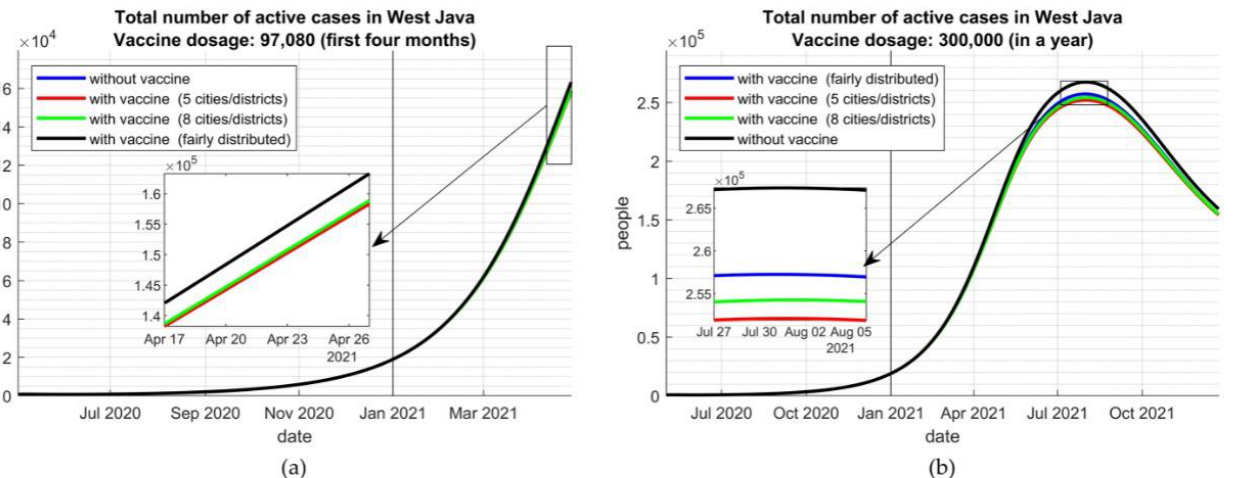
Figure 3. The number of active cases with several scenarios of vaccine distribution given ( a ) the severely lacking vaccines — 97,080 dosages in the first four months, ( b ) 300,000 dosages in one year, and ( c ) the optimum available vaccines — 33,000,000 dosages in one year. Assuming that the government could not improve the vaccine capacity within the first year, there would be an estimated 300,000 inoculation in one year until December 2021. By this assumption, after six months, we could see the effects of targeted vaccine allocation (Figure 3b). Targeted vaccine allocation to the five and eight cities/districts with the highest COVID-19 incidence would deliver more benefits than distributing the vaccine equally to all districts. At the peak of the COVID-19 transmission curve, targeted vaccine allocation could reduce the new cases, ranging from 5,000 to 8,000 cases. However, after reaching the curve peak and the decreasing infection rate, there would be no significant differences between scenarios. The effect would be more significant if the number of vaccines could be increased as targeted, 33 million dosages in one year. By this assumption, the targeted allocation would not be effective, while equal distribution between districts would provide the most benefit to halting the infection rate (Figure 3c). 4. Discussion The findings suggested that, in case of lacking available vaccines, targeted vaccine allocation based on the burden of COVID-19 cases could increase the benefit of the COVID-19 vaccination program. The targeted allocation to the district with the highest